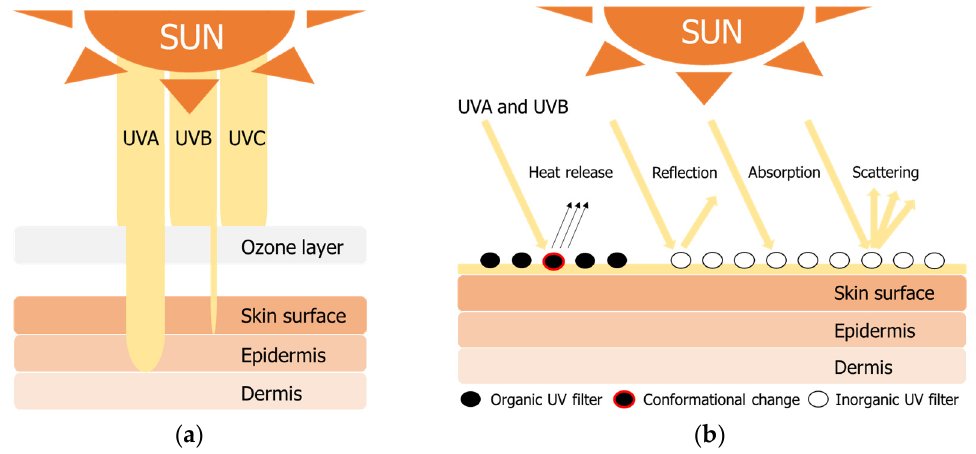
Figure 1. UV radiation properties ( a ) penetration into human skin and ( b ) protection mechanisms of organic and inorganic filters. Table 1. US FDA-approved active ingredients for use in commercial sunscreen products.